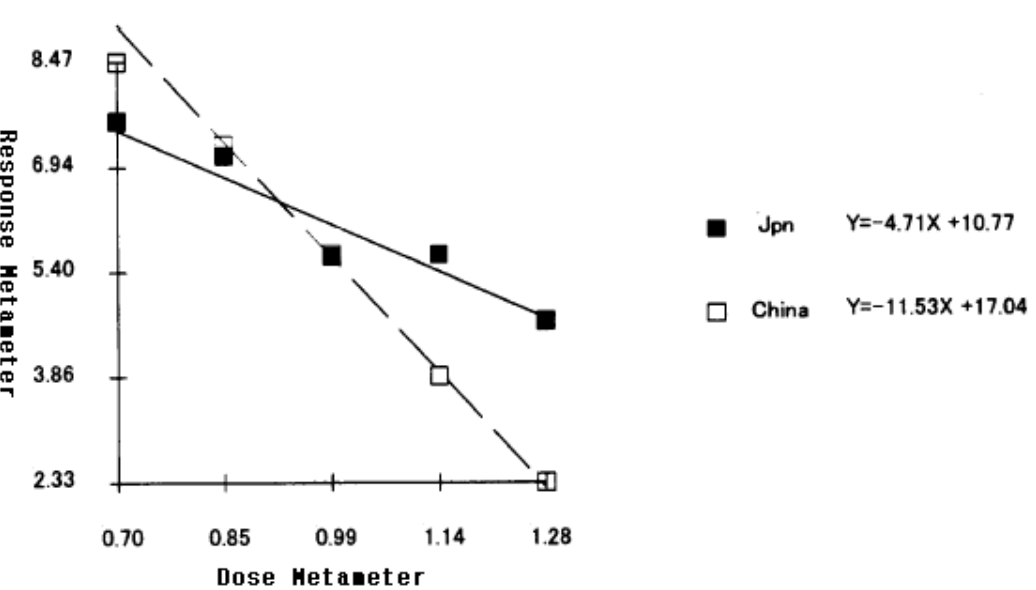
) of Agkistrodon halys (Jpn) and 50